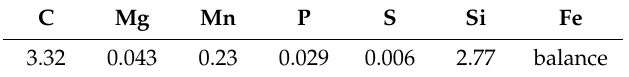
Table 28. Chemical composition of FCD450 ductile cast iron (% by mass)